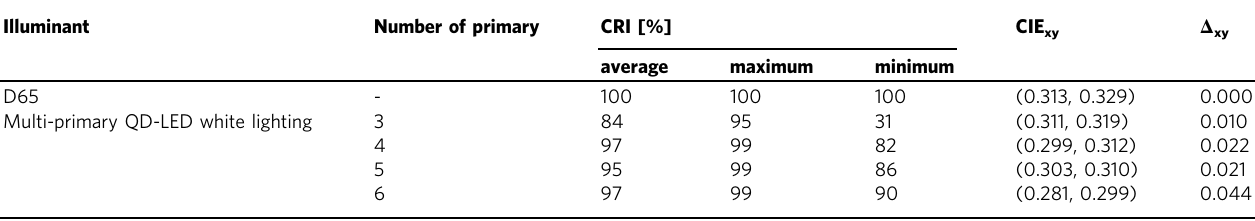
Table 1 Chromatic properties of the multi-primary white lightings optimised in this study.